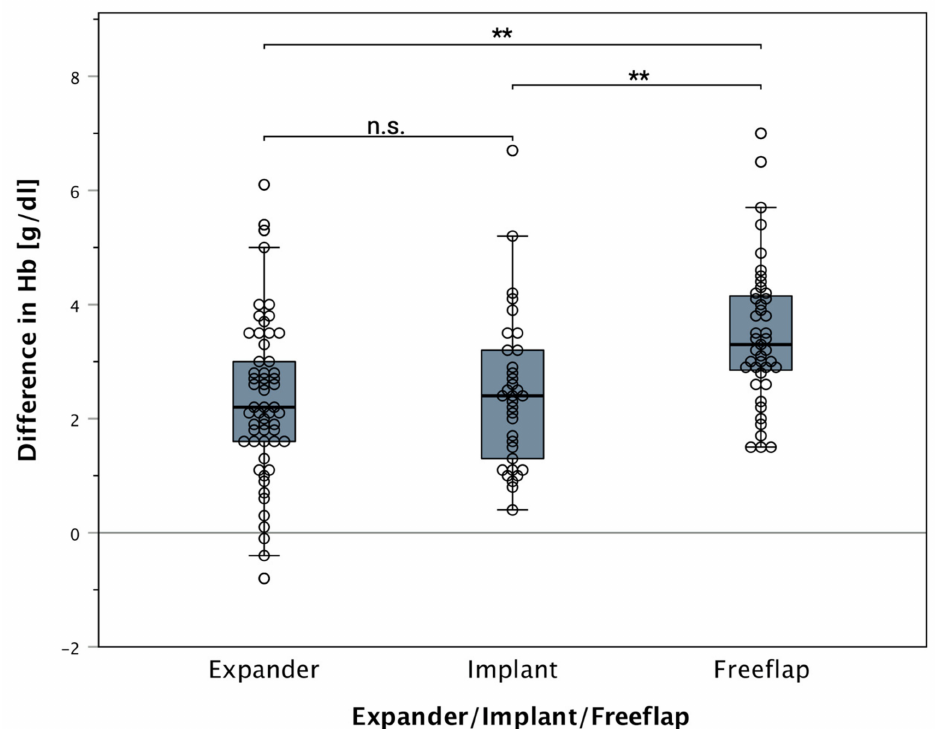
Figure 3. Boxplot of pre- and post-operative hemoglobin difference and used reconstruction method: patients reconstructed with autologous tissue showed a statistically significant drop in hemoglobin levels postoperatively (free tissue flap: 3.3 g/dL). Prosthetic-based reconstructions showed no significant hemoglobin decrease. (Median: tissue expander: 2.2 g/dL, definitive implant: 2.4 g/dL). “n.s.” indicating no significance. The stars (**) indicating a statistically significant difference between the groups ( p < 0.05). All data points (including outliers) can be seen as scattered dots overlying the